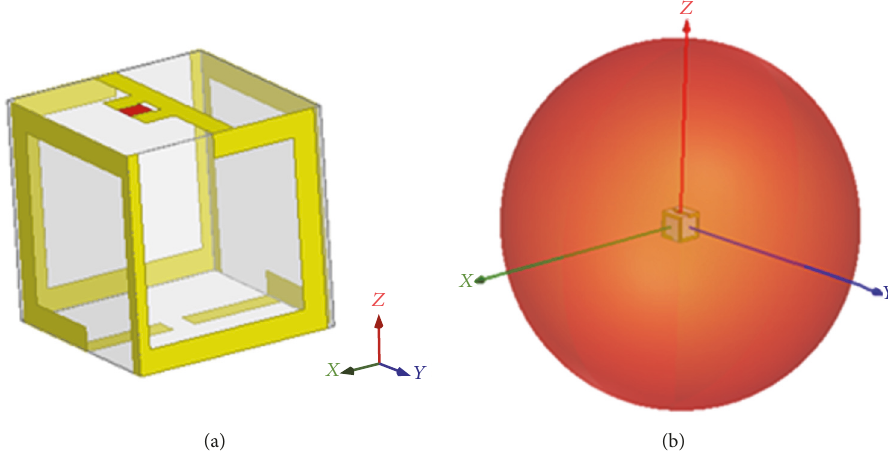
Figure 5: 3D cubic antenna: (a) form and (b) radiation pattern.